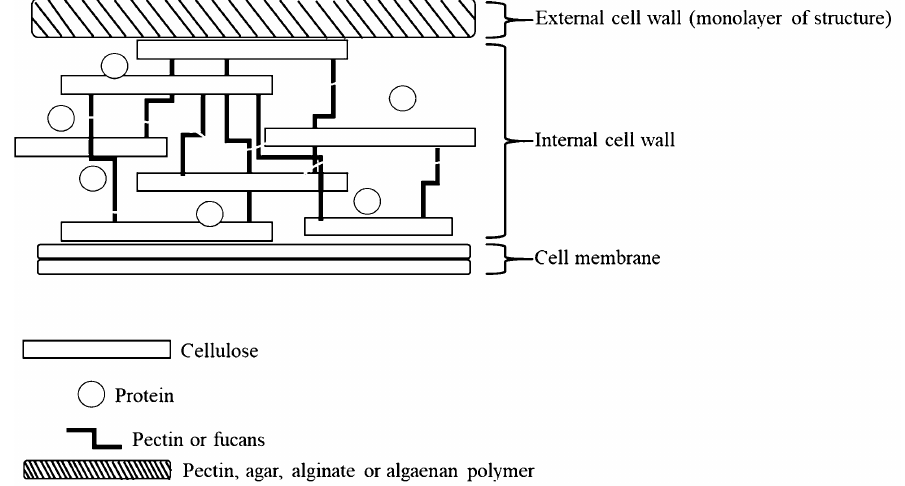
Figure 3. The structure of microalgae cell wall. Concepts were based on Velazquez-Lucio et al. (2018)